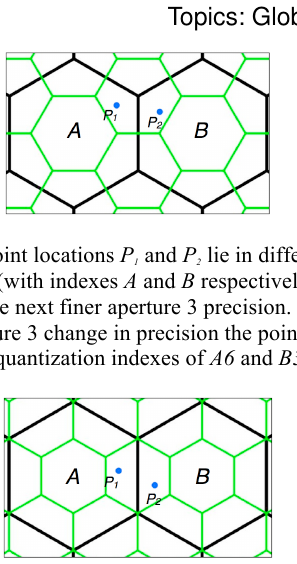
Figure 4(b). Point locations P and P lie in different coarser 1 2 precision cells (with indexes A and B respectively), but in the same cell at the next finer aperture 4 precision. The points would have multi-precision quantization indexes of A4 and B3